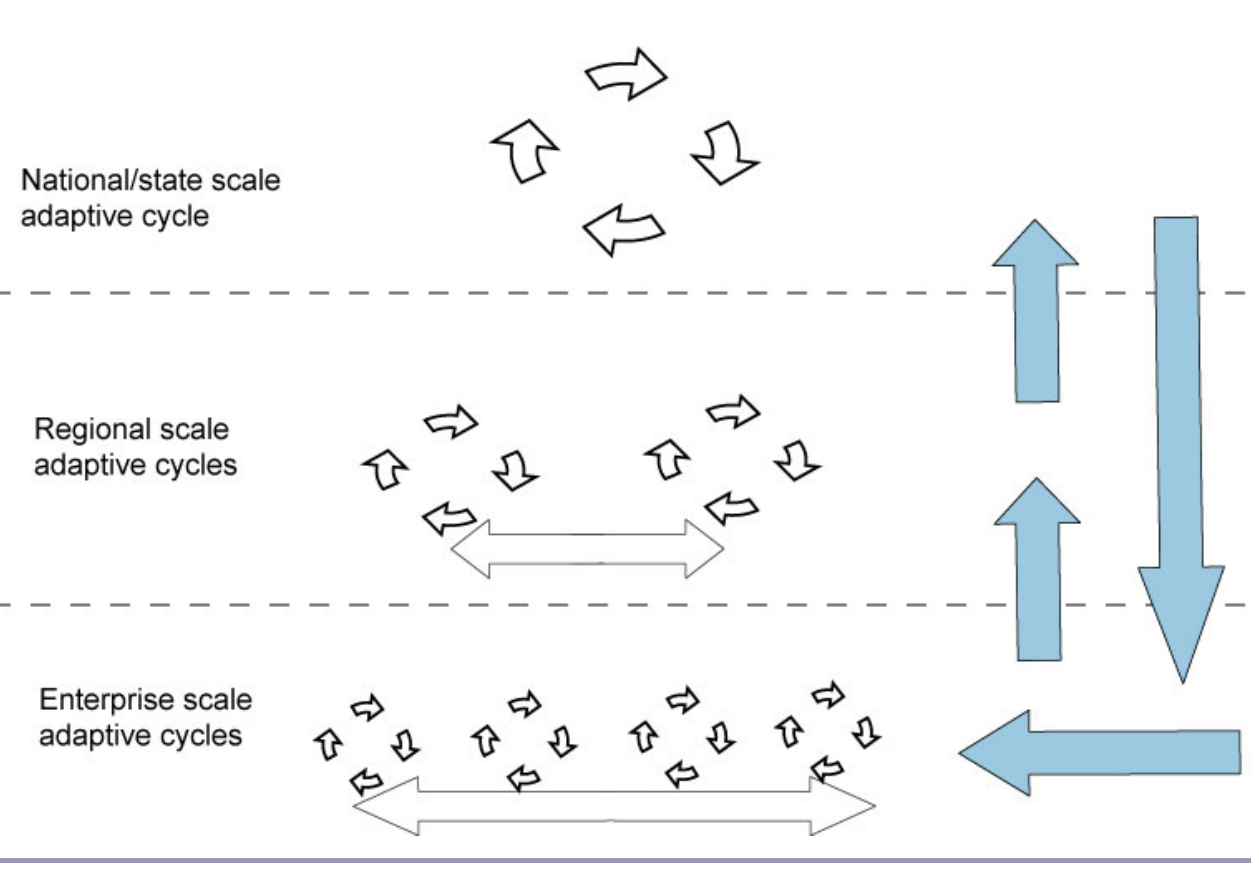
Fig. 2. Adaptation of Australian pastoral enterprises involves cycles of adaptation at multiple scales, which have both bottom-up and top-down